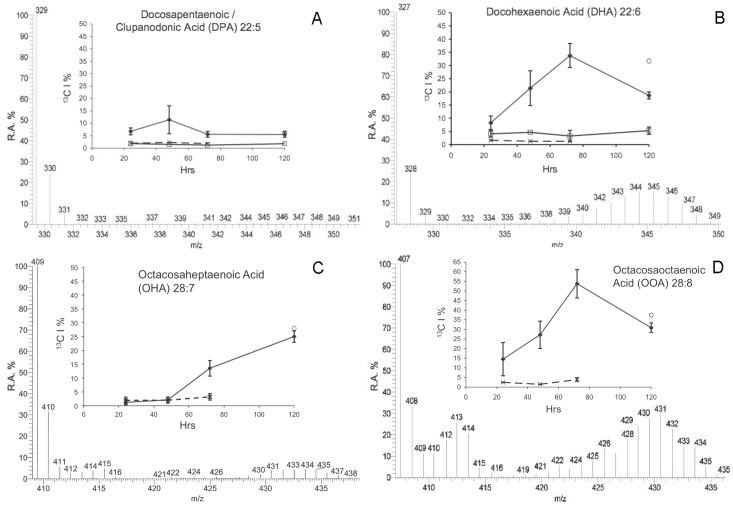
See
Figure 2
 legend.